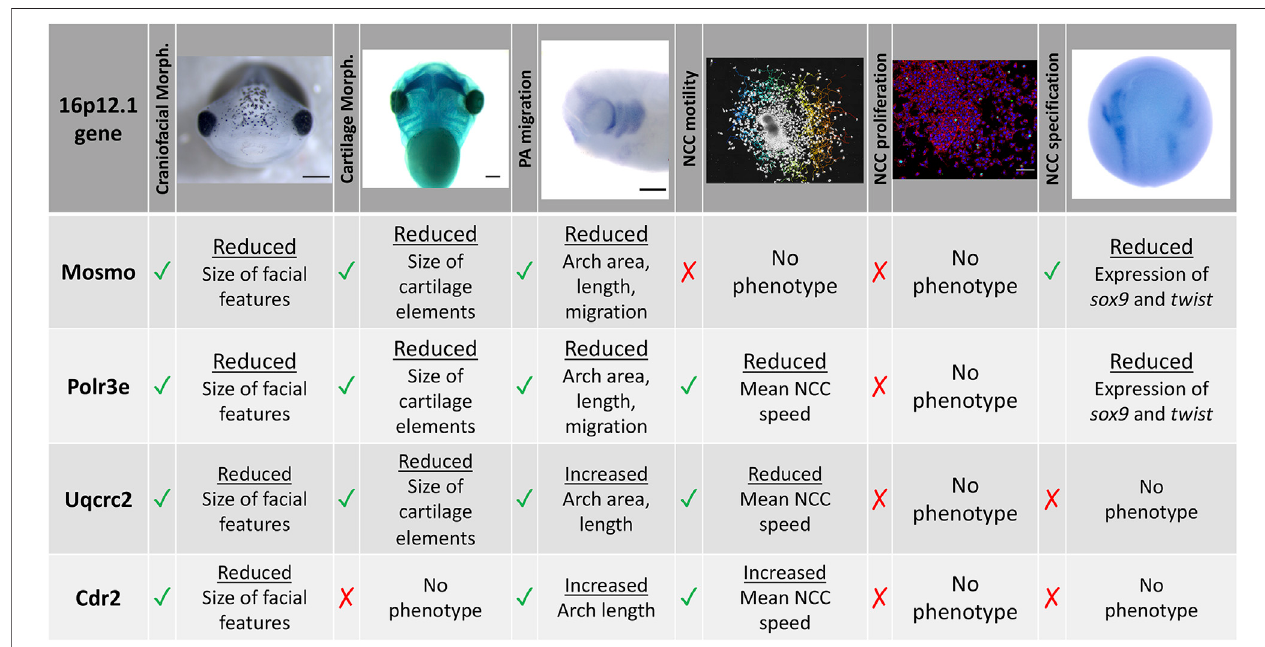
FIGURE 7 | Summary table of 16p12.1-affected gene craniofacial, cartilage, and NCC phenotypes. Partial depletion of 16p12.1-affected genes demonstrates numerous impacts on craniofacial, cartilage, and CNC development. Tissues are denoted as affected (checked box) if phenotypes were signi fi cantly different from control ( p < 0.05); see individual fi gures for data distribution and